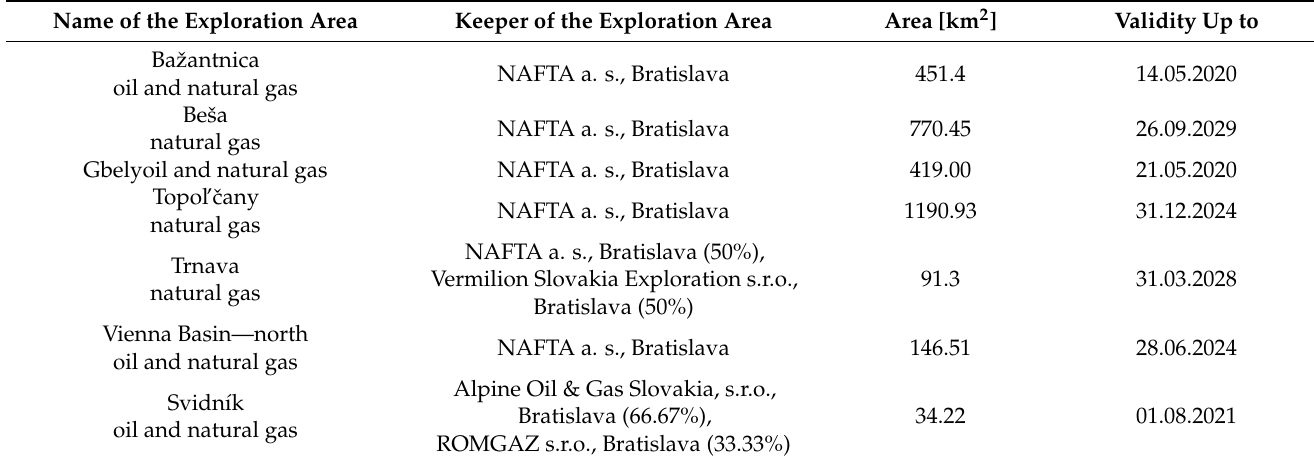
Table 1. List of all valid exploration territories for oil and gas in Slovakia (2020), (source: elaborated by authors based on